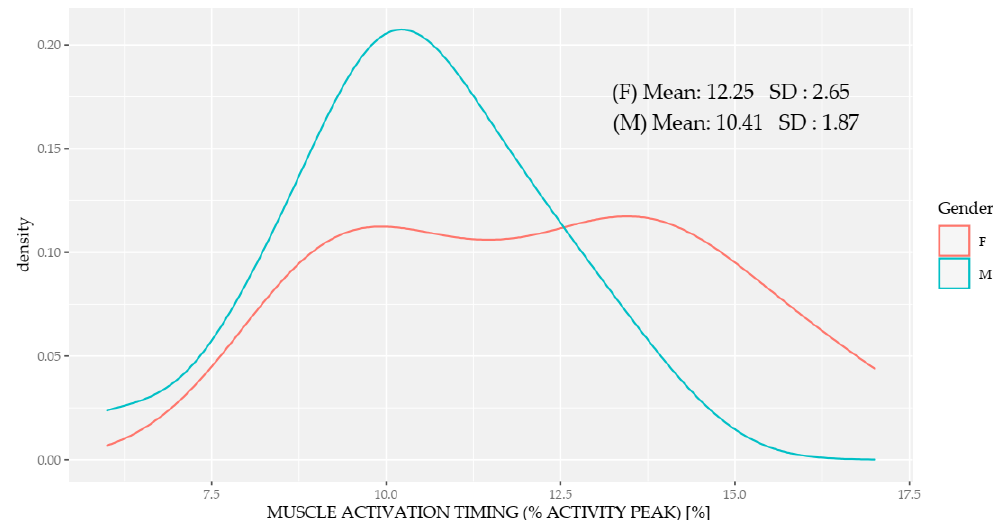
Figure 3. Percentage of the total activation of the vastus medialis during the running cycle distributed between women (F) and men (M). The distribution of the mean and SD were more homogeneous in men.